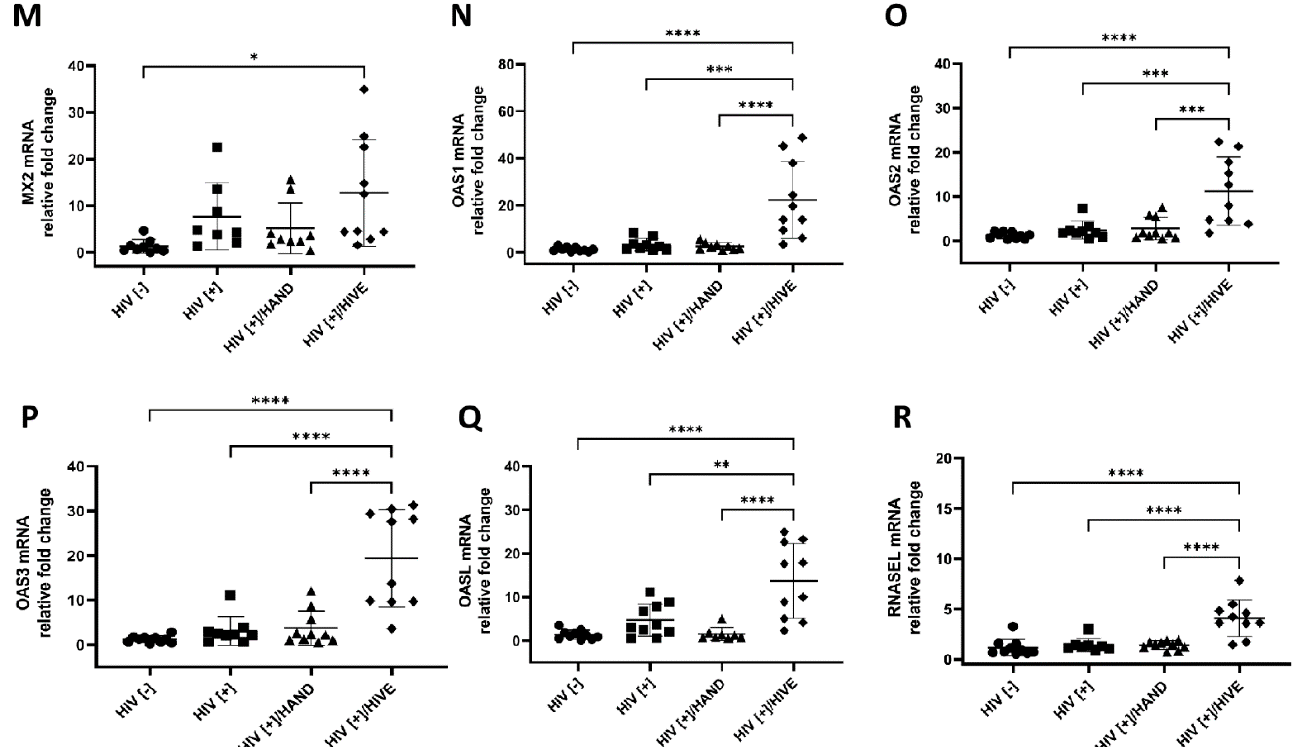
Figure 4. Relative host restriction factors’ mRNA expression levels . Highly upregulated RFs identified in the RNA-seq database were subjected to qRT-PCR validation. The mRNA expression levels for each gene ( A – R ) were normalized to GAPDH and are reported as the fold change relative to the HIV[ − ] control group. The horizontal lines represent the mean values and the error bars represent the standard deviation ( *, p < 0.05; **, p < 0.01; ***, p < 0.001; **** , p < 0.0001 ).